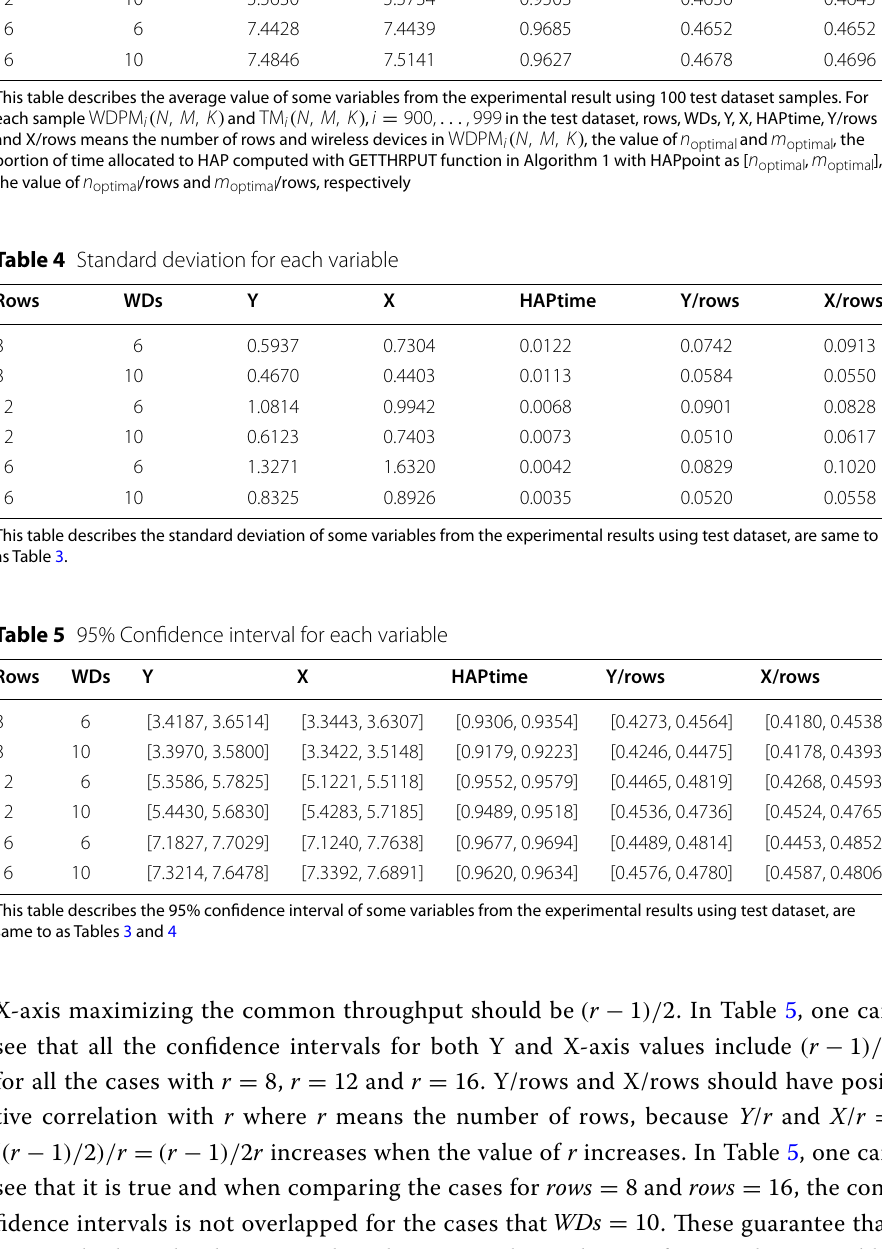
Table 3 Average values for each variable